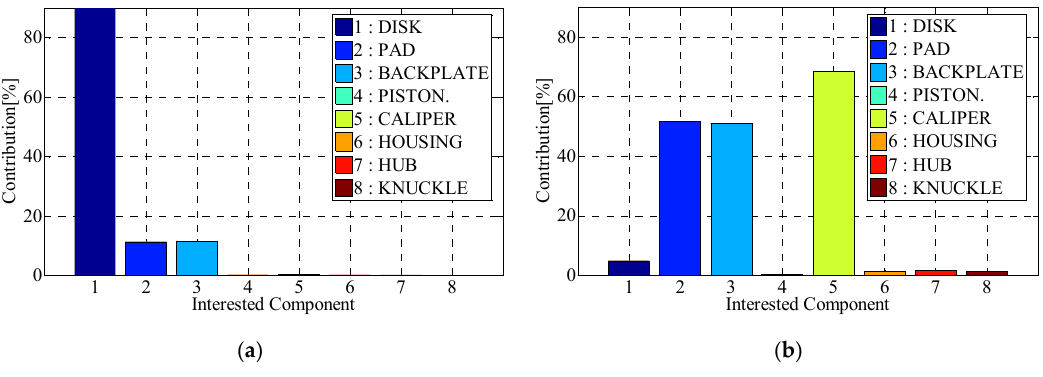
Figure 9. Contribution analysis of assembled brake system: (a) 3.4 kHz and (b) 6.4 kHz.